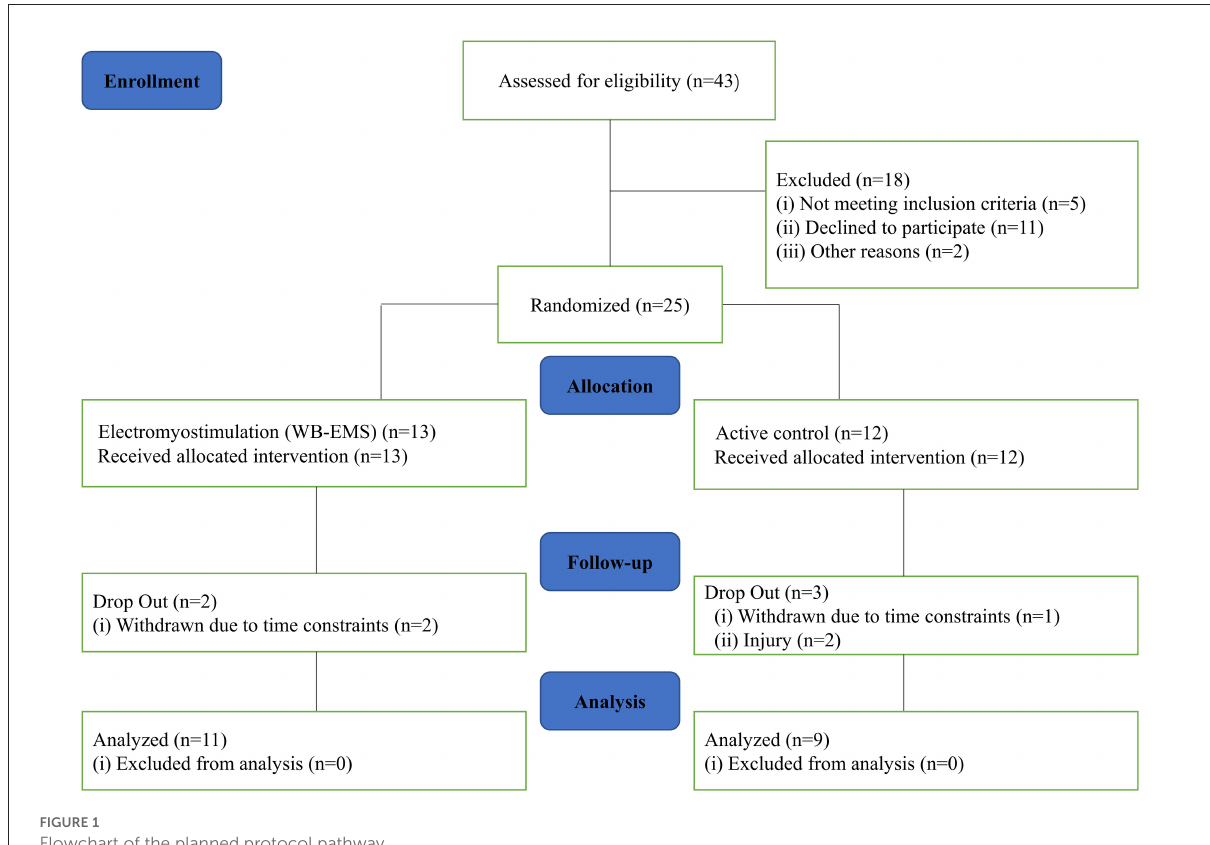
FIGURE1 Flowchart of the planned protocol